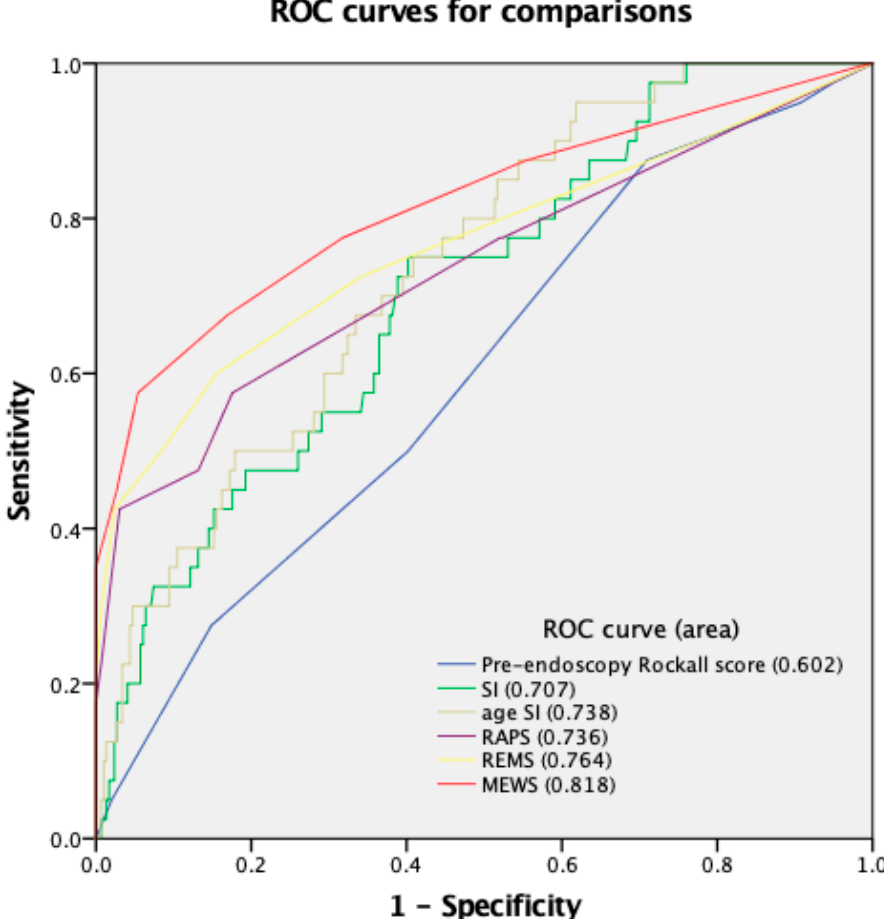
Figure 1. ROC curves for six scoring systems in evaluation of mortality for patients older than 65